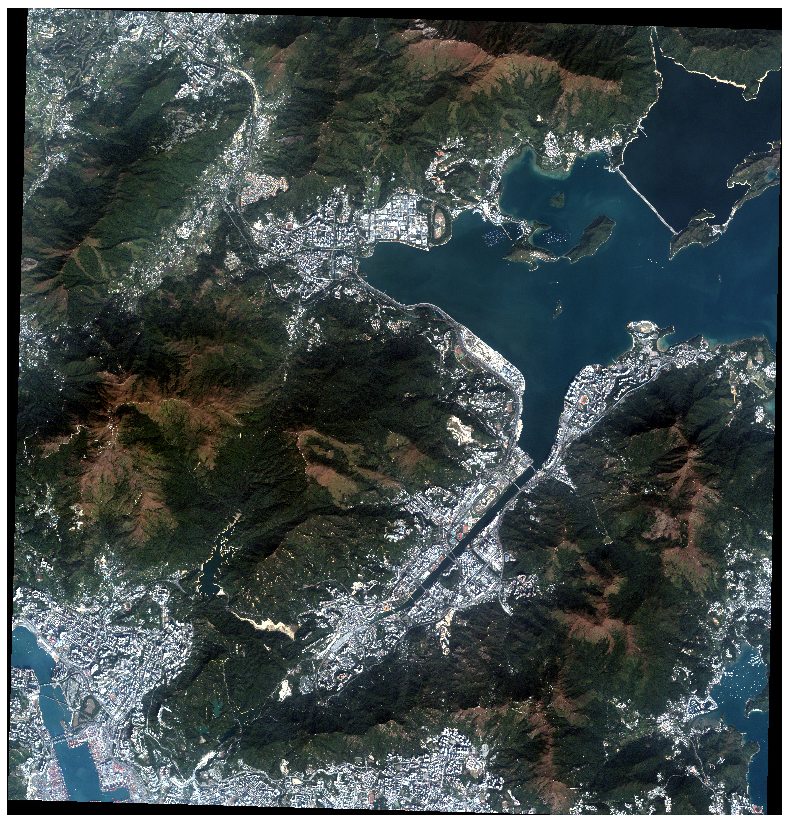
Figure 4. Territorial framework of the investigated area from a QuickBird satellite.